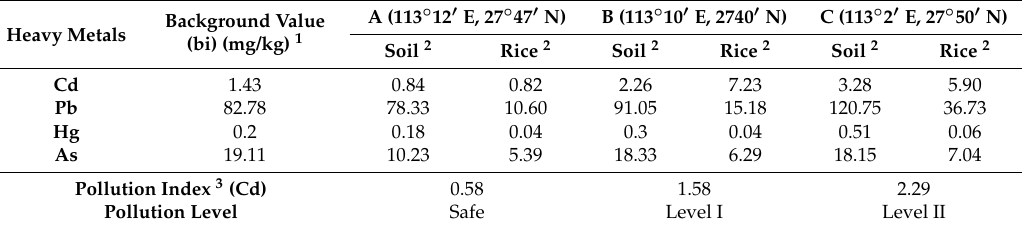
Figure 1. Location map for the study areas in the city of Zhuzhou, Hunan Province, China. DOY is the abbreviation for the day of year. ( a ) The location of Zhuzhou city in China; ( b ) the location of the study areas in Zhuzhou city; ( c ) diagram for the rice planting pattern; ( d ) the CCD images selected by the key periods in study area B. Table 1. Content of heavy metals in the soil and rice in the study